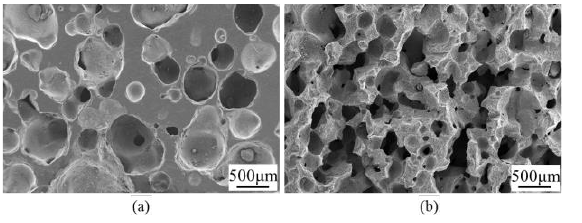
Figure 7. SEM images of SiC porous ceramics with different amounts of SDS: ( a ) 0 and ( b ) 0.1 wt.%. Table 3 shows the properties of the SiC porous ceramics with different amounts of SDS. It can be seen that the addition of SDS increases the porosity and decreases the flexural and compressive strength of SiC porous ceramics. Table 3. The properties of SiC porous ceramics with different amounts of SDS. SDS Amounts (%)